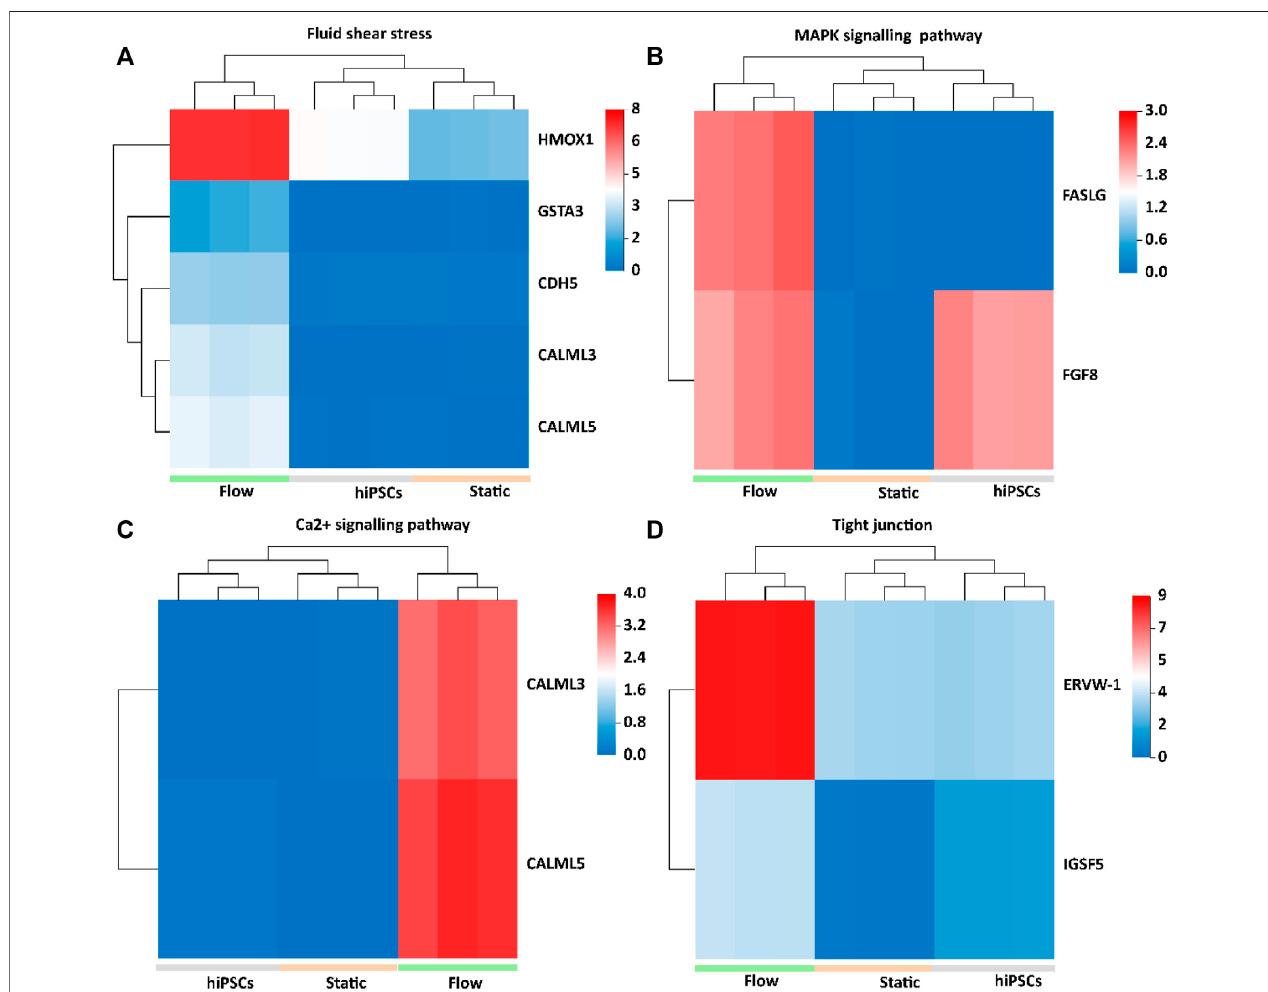
FIGURE 6 | Heatmap of upregulated DEGs in 3D tissues under the fl ow condition, which were implicated in fl uid shear stress, MAPK signaling pathways, Ca2 + signaling pathway, and tight junction. (A) HMOX1, GSTA3, CDH5, CALML3, and CALML5 upregulated in 3D tissues were enriched in fl uid shear stress pathways. (B) FASLG and FGF8 upregulated in 3D tissues were enriched in the MAPK signaling pathway. (C) CALML3 and CALML5 were enriched in the Ca 2+ signaling pathway. (D) ERVW-1, crucial for STB infusion, and IGSF5, a tight adhesion protein, were enriched in the tight junction.